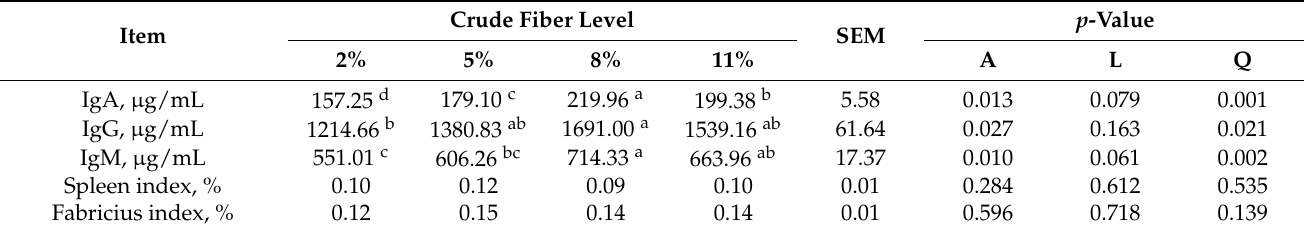
Table 5. Effects of dietary CF level on the immune function of broilers on day 42.